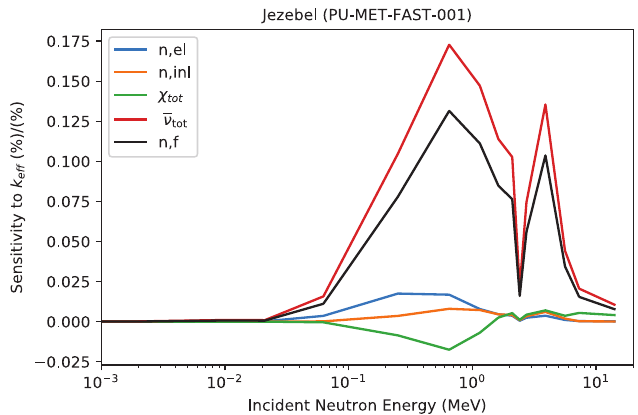
Fig. 2. The sensitivities of k eff of the Jezebel critical assem- bly [22] to the ENDF/B-VIII.0 239 Pu elastic, inelastic, (n,f) cross sections, total average neutron multiplicity ( ν tot ) and total spec- trum ( χ tot ) are compared. These sensitivities were calculated as part of the work related to